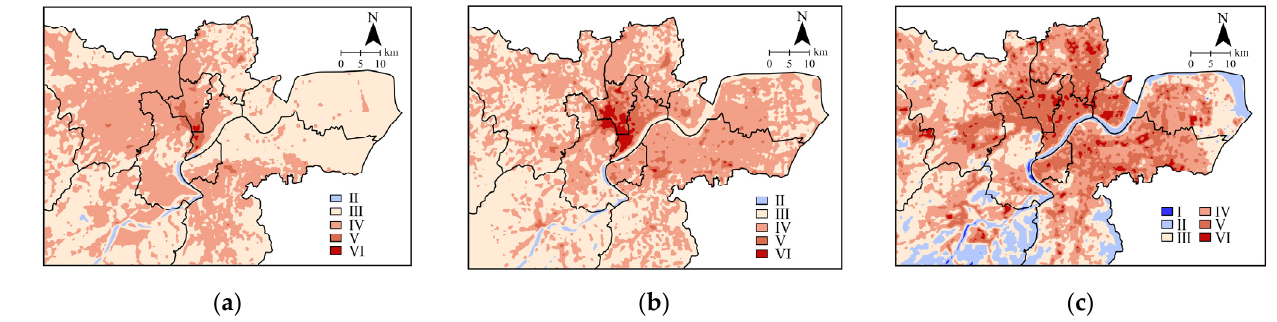
Figure 10. Distribution of Hangzhou high temperature’s influence on negative emotions during the three periods in typical periods: ( a ) 1984; ( b ) 1998; ( c ) 2020.